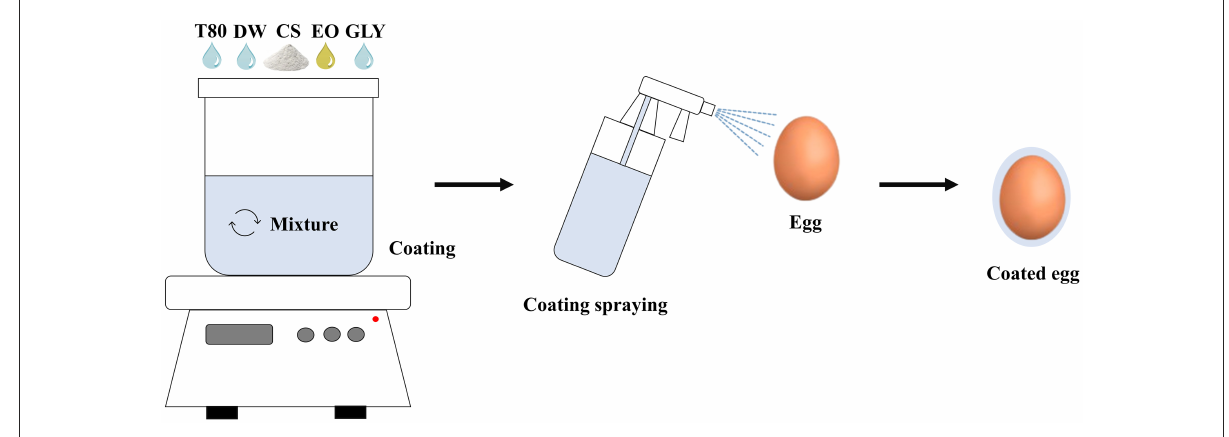
FIGURE2 Preparation and application of coatings on eggs. CS, cassava starch; DW, distilled water; GLY, glycerol; EO, essential oil; T80, Tween 80.